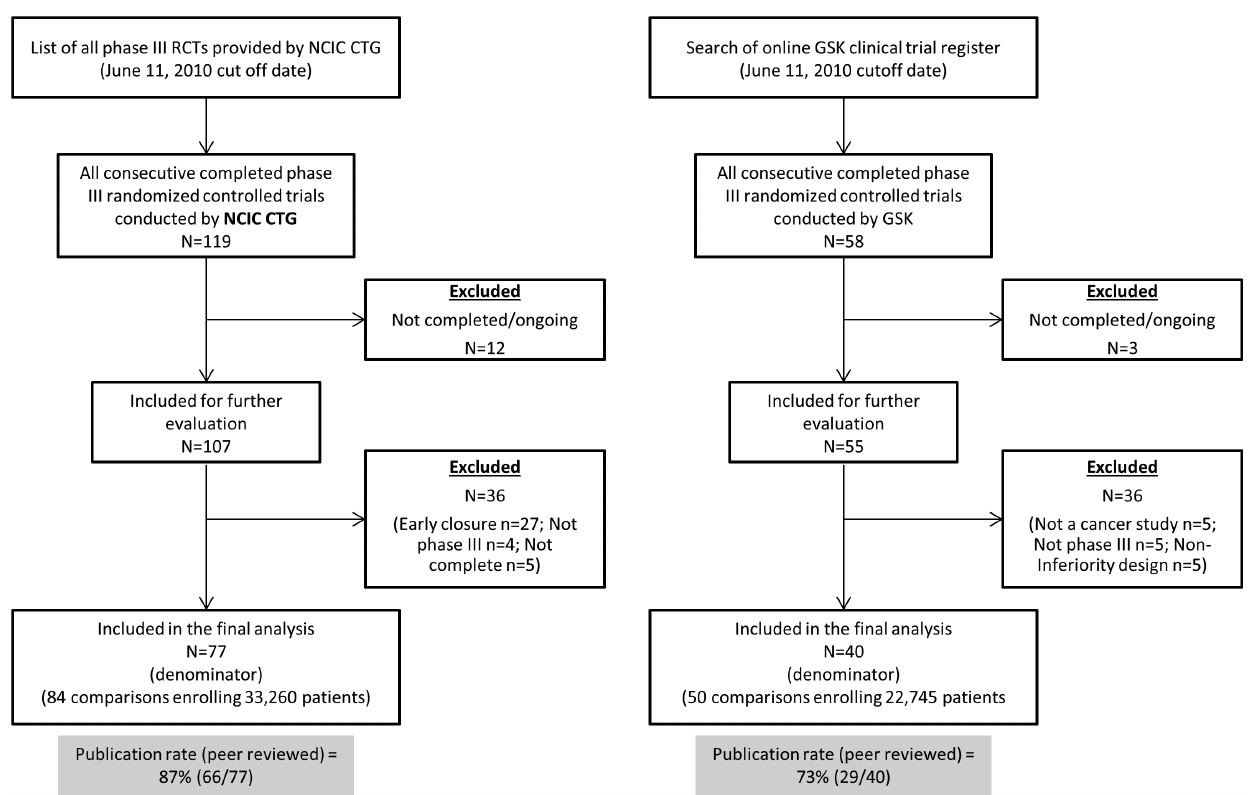
Figure 1. PRISMA flow diagram depicting process of identification and selection of studies.